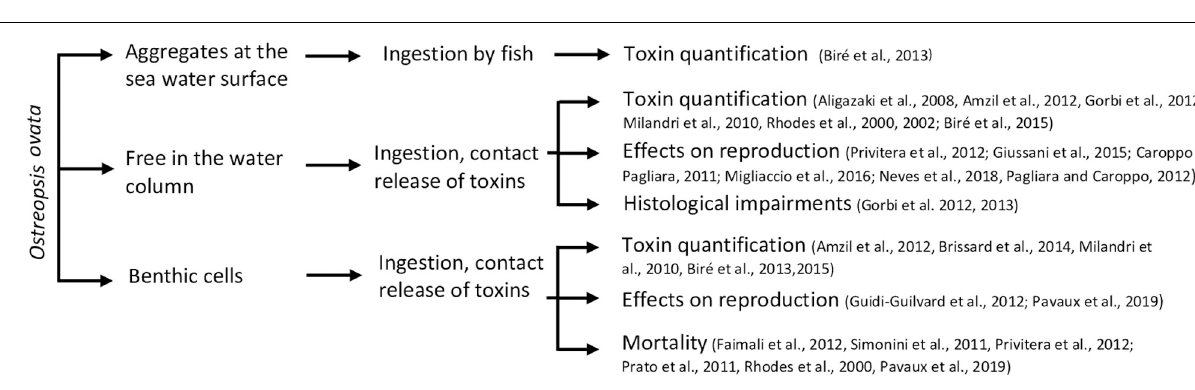
FIGURE 3 | Summary of known interactions between Ostreopsis cf. ovata and flora.